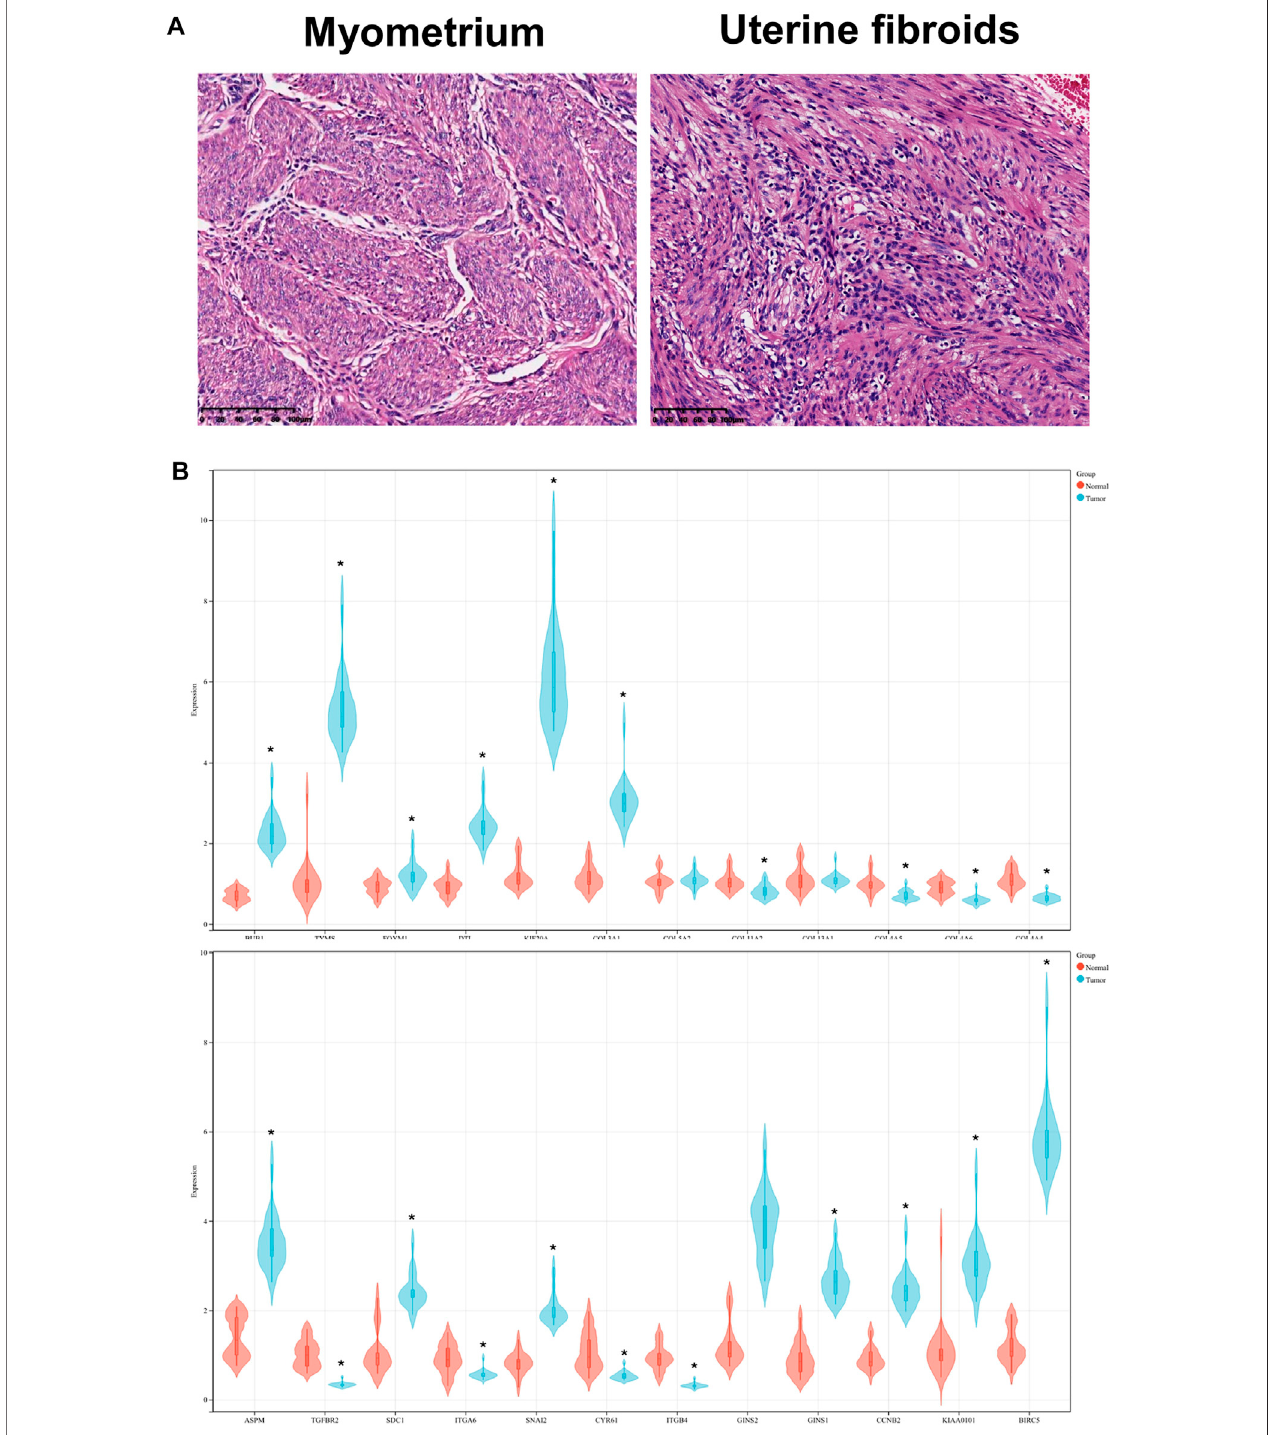
FIGURE 8 | (A) HE staining of UF tissues and myometrium. (B) Validation of hub DEGs expression in UF by RT-PCR.